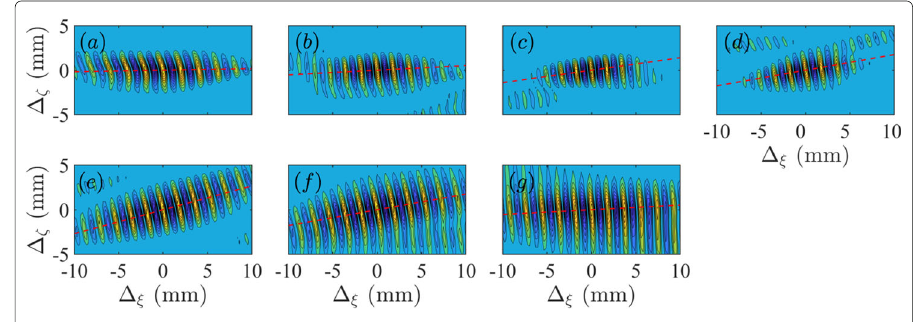
(cid:2) (cid:3) (cid:7) ζ /(cid:7) ξ = 1° in a , 3° in b , 8° in c , 10° in d , 15° in e ,